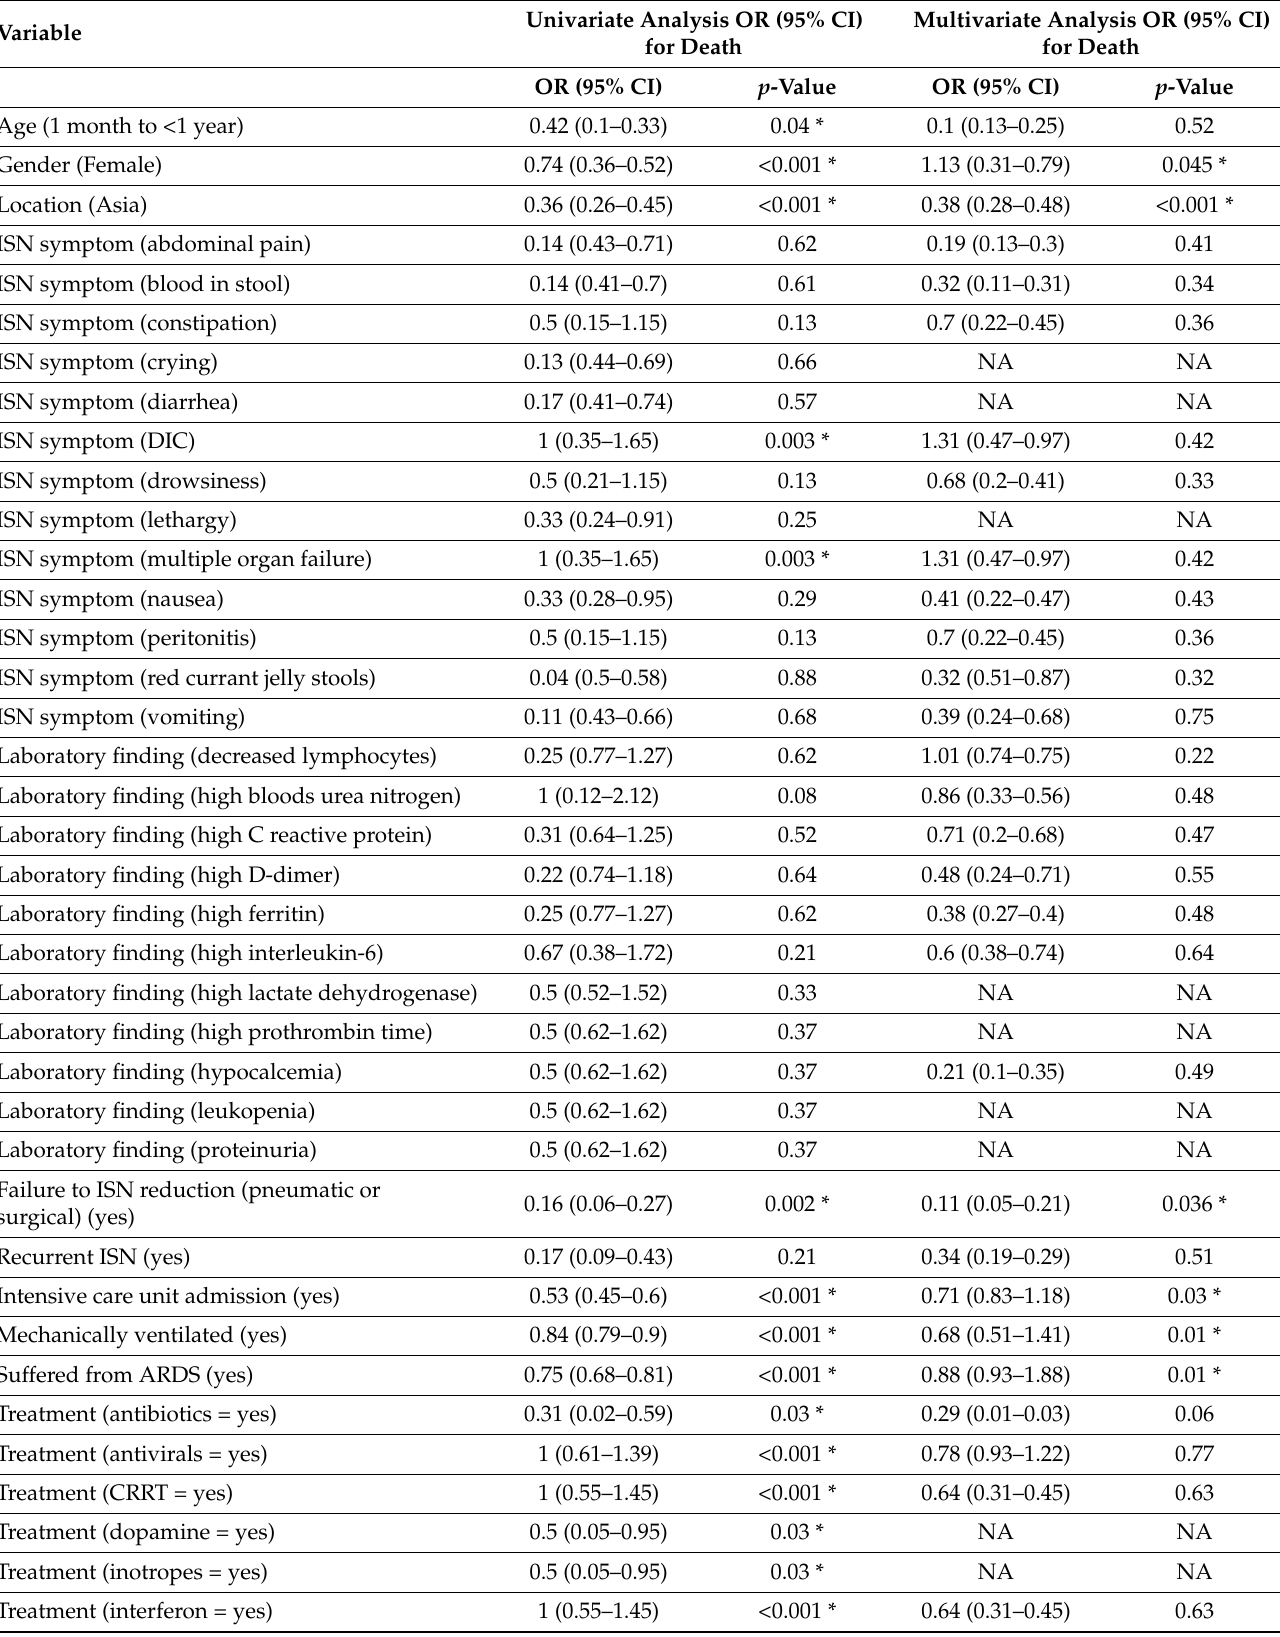
Table 3. Predictors of mortality in pediatric patients hospitalized for ISN and SARS-CoV-2 (n =